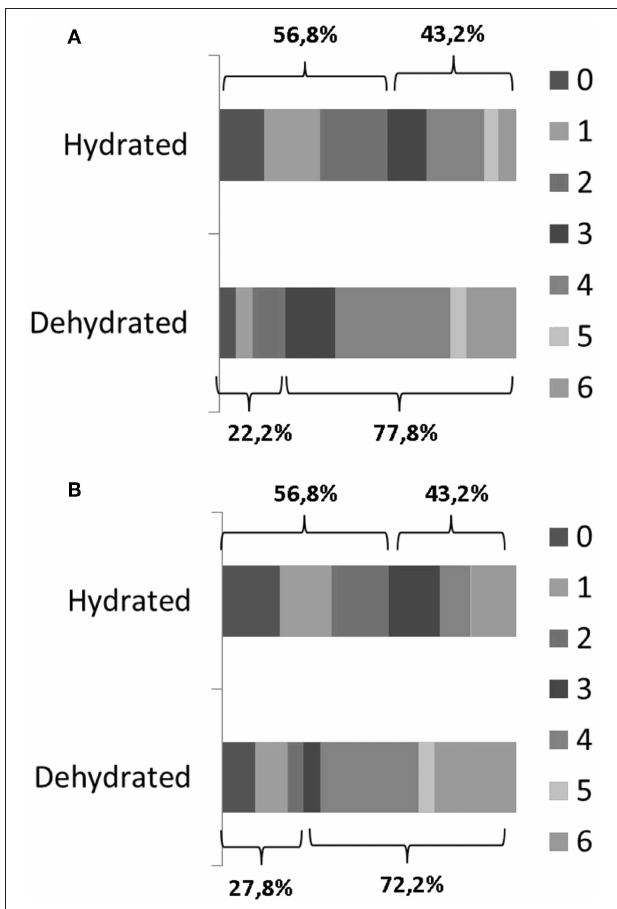
FIGURE 1 | Comparison of mRS scores in dehydrated patients ( n = 18) and non-dehydrated patients ( n = 185) at discharge (A) and after 3 months (B) .